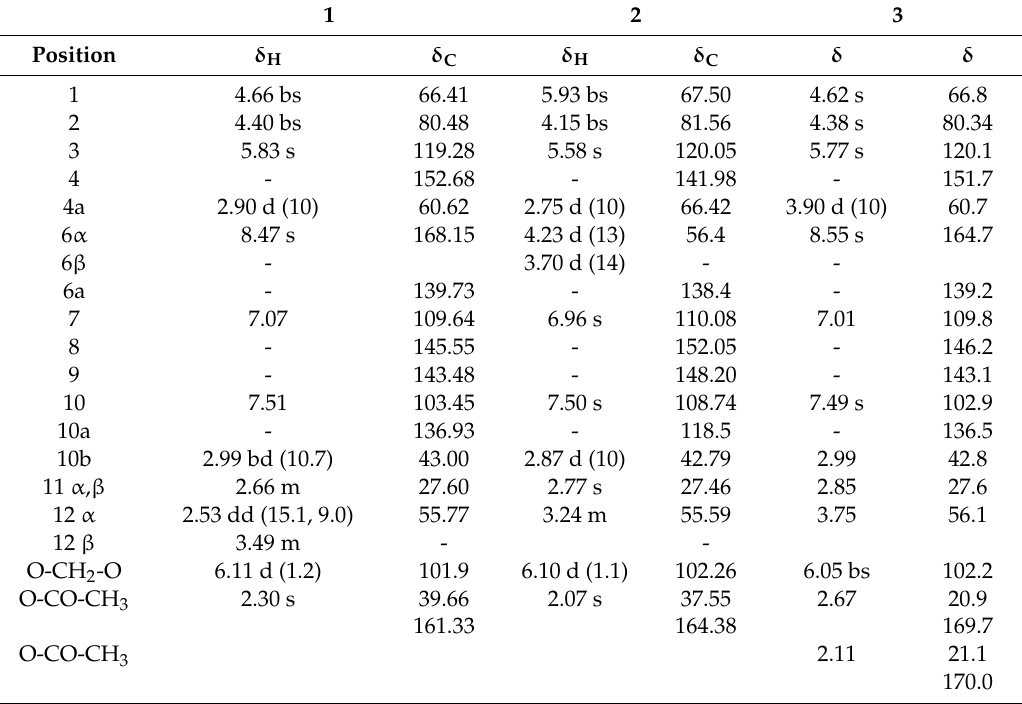
Table 5. 1 H and 13 C-NMR data of alkaloids 1, 2, and 3 ( J in Hz) in CDCl 3 .